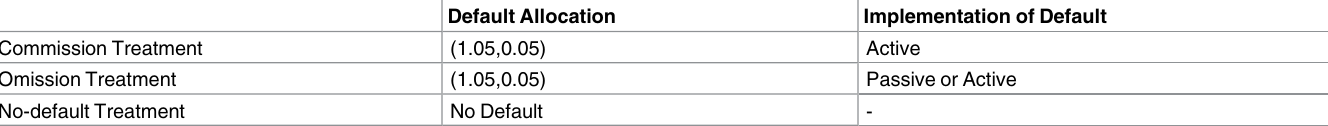
Table 4. Overview of treatments in Experiment 2: Choice between (1.05,0.05) and